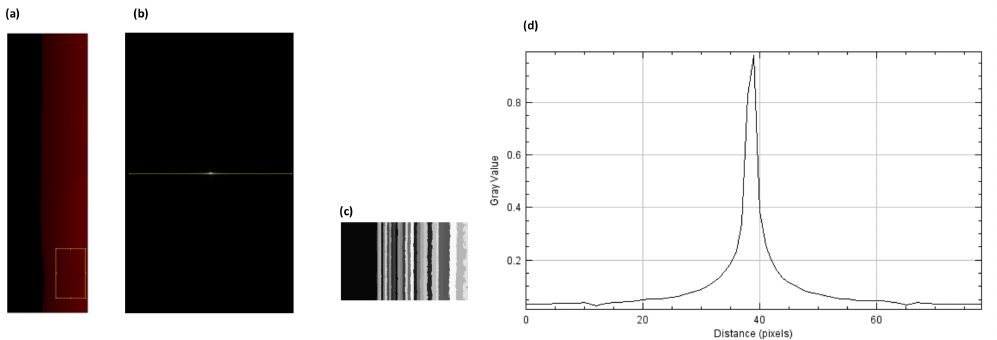
Figure 12. ( a ) Tire sidewall linearized image selecting a homogeneous region. ( b ) Discrete Fourier Transform (DFT) transform. ( c ) K-Means image processing of the selected homogeneous region (K = 35). ( d ) DFT power frequency spectrum across the yellow line shown in Figure 12b.